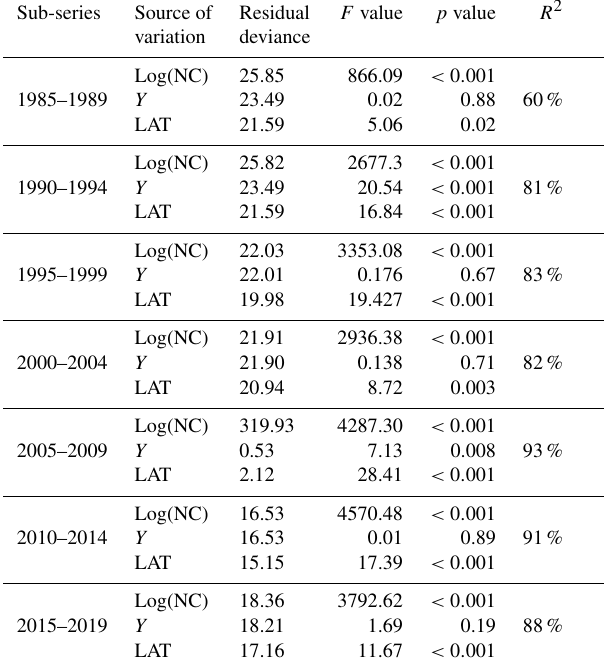
Table 1. Results of analysis of deviance for the statistical models fitted to the data for every 5-year sub-series. Residual deviance rep- resents the degree in which the response variable can be predicted by model predictors. The higher the value, the better the model is able to make predictions. The F value is the rate of model variance; it provides a way to compare the fitted model against a model with only intercept and no predictors. Higher F values represent better fits of the data to the model. F values provide the significance of the effect of each predictor in the models. Values equal to or lower than 0.05 represent a significant effect. R 2 is the coefficient of de- termination; it represents the percentage of variance in the response variable that is explained by the fitted